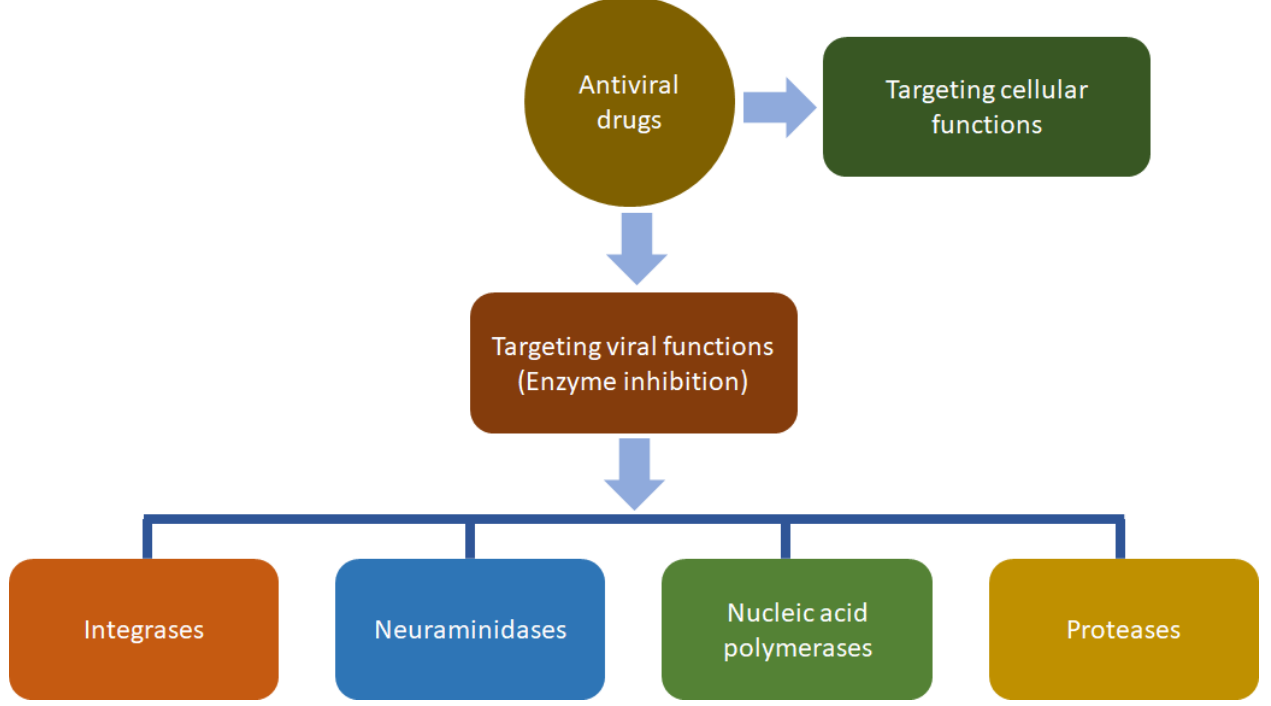
Figure 11. Common modes of action of the currently available antiviral drugs.